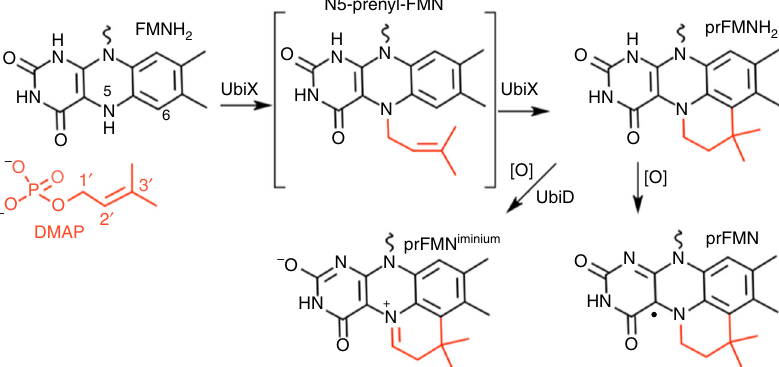
Fig. 1 UbiX and UbiD act in concert to produce prFMN iminium . Proposed mechanism for fl avin prenyltransferase activity by UbiX, followed by transfer of prFMNH 2 to UbiD and subsequent oxidative maturation to the active prFMN iminium